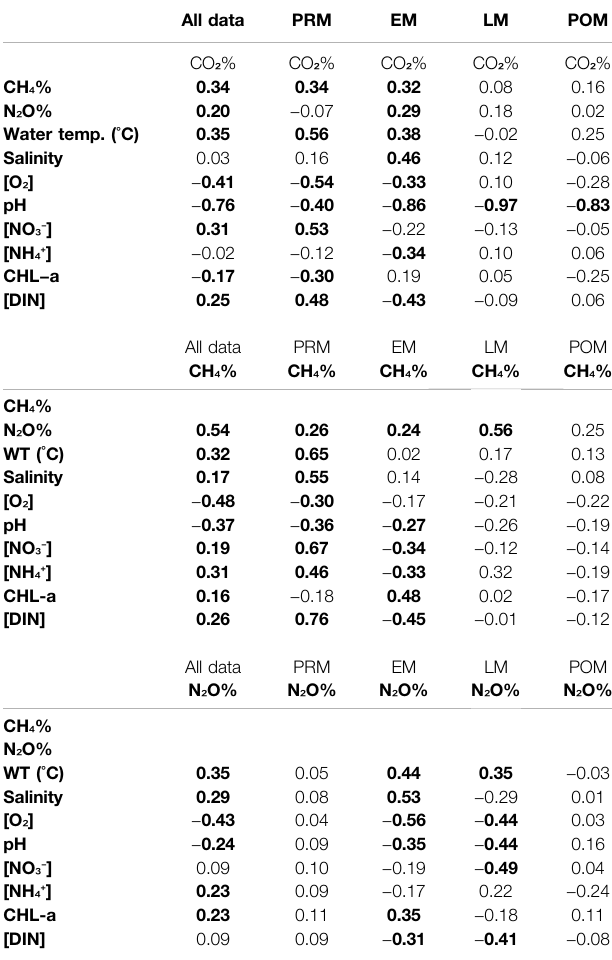
TABLE 1 | Spearman ’ s correlation coef fi cient for pooled data (n = 225) and by seasons (n = 57) (values marked in bold are signi fi cant ( p < 0.05). All